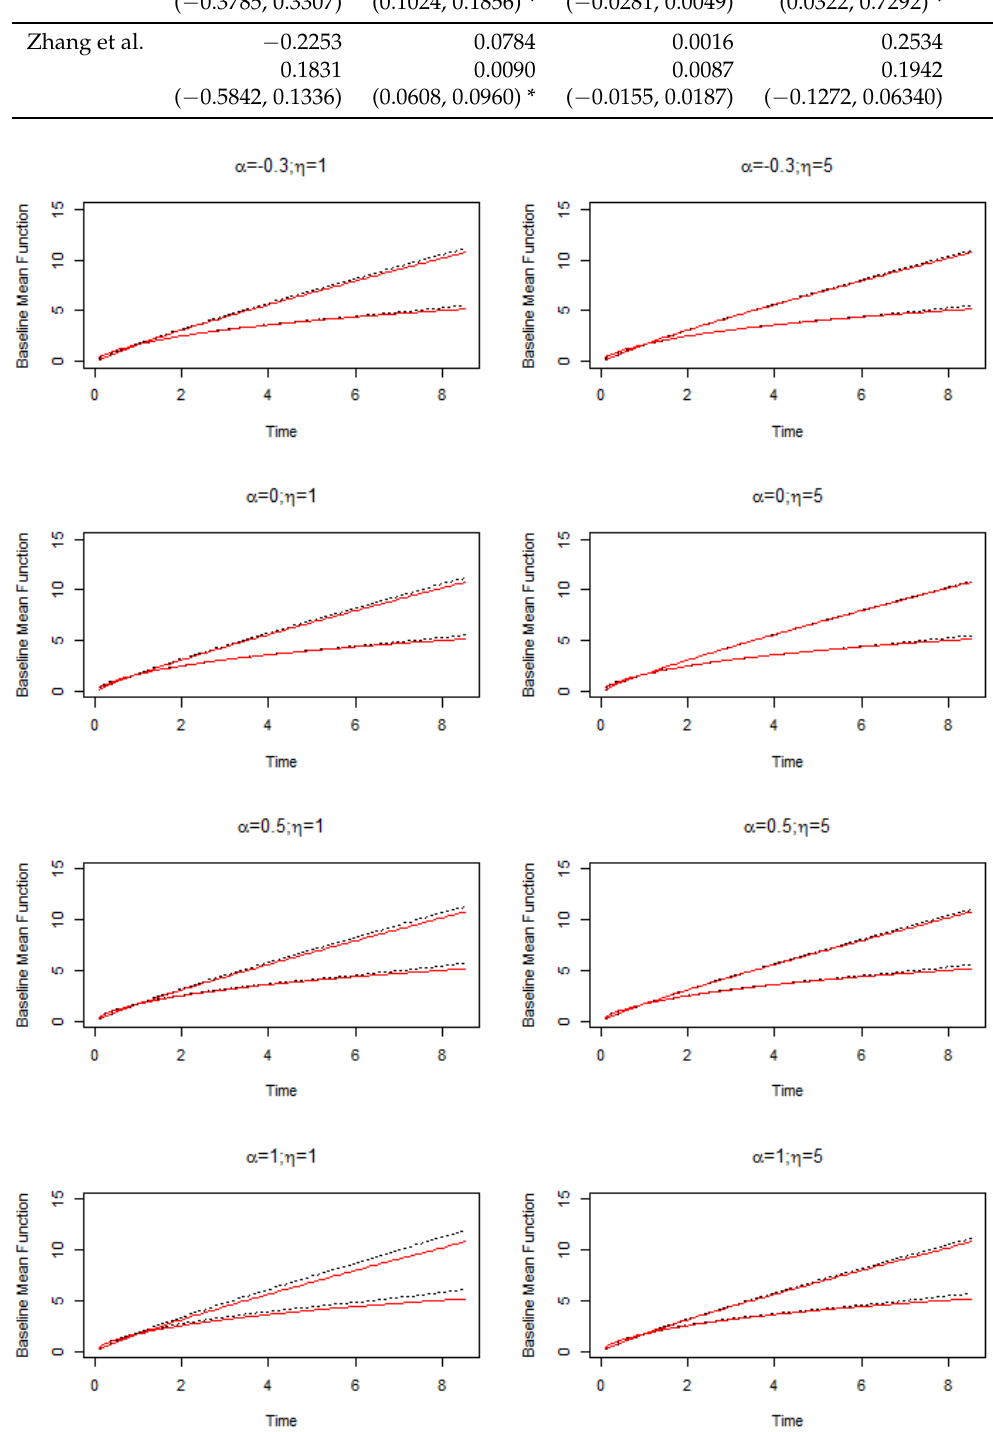
Figure A2. Simulation results: estimation of baseline mean function for models with different α and η values. The solid lines represent the true baseline mean function and the broken lines represent the estimated baseline mean